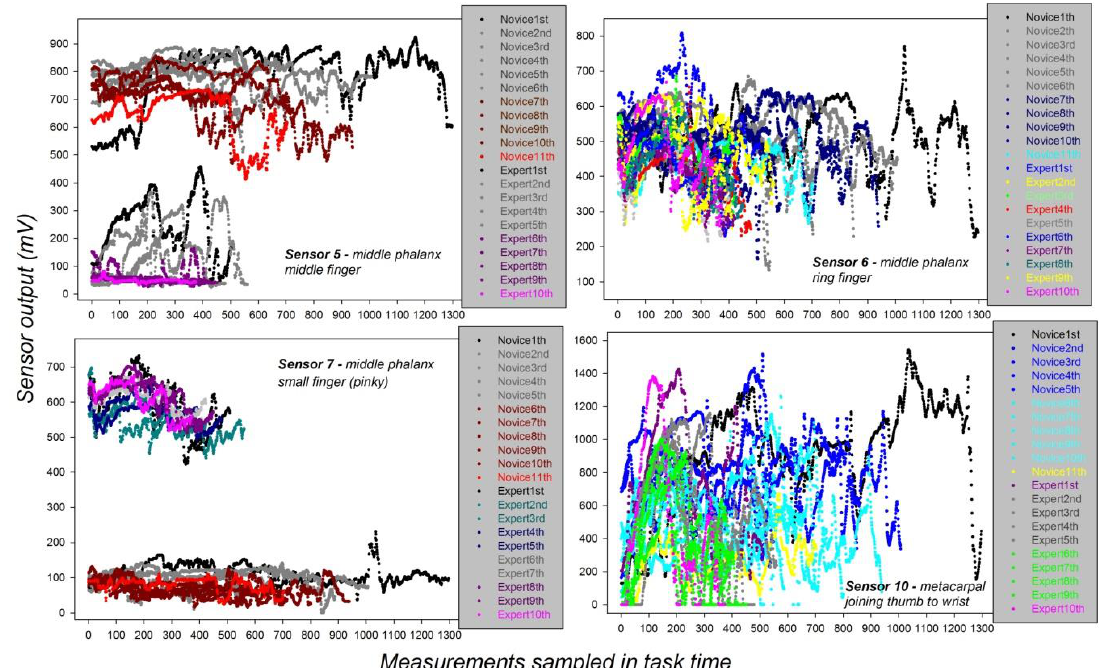
Figure 9. Distinct grip force profiles, plotted separately for each of the four specific sensor locations, from the successive sessions of the expert and the novice performing the pick-and-drop task on the robotic system with their dominant hands.